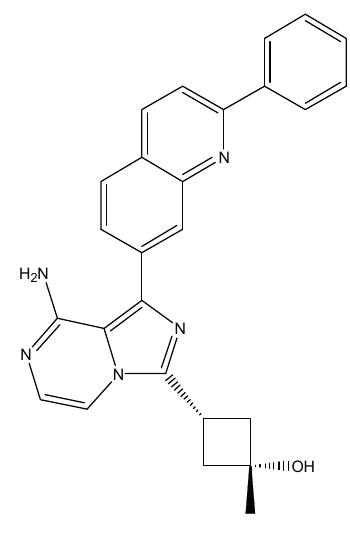
Figure 18. Structure of